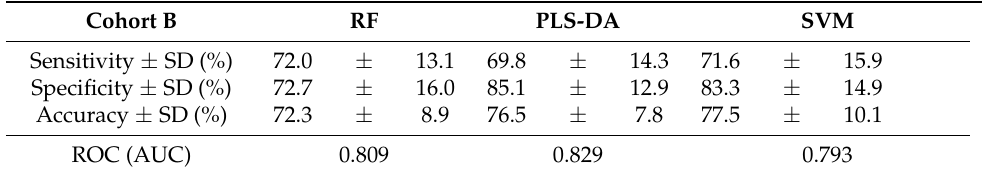
Figure 4. Receiver operating characteristic (ROC) curve analysis calculated from a partial least squares discriminant analysis (PLS-DA) model performed on Cohort B. Point A shows the point of maximum sensitivity and point E shows the point of maximum specificity when the model is tuned to give a specificity or sensitivity of 45%, respectively, as highlighted by the light blue square. Point B shows the point of maximum sensitivity and point D shows the point of maximum specificity when the model is tuned to give a specificity or sensitivity of 60%, respectively, as highlighted by the darker light blue square. Point C represents the balance point between sensitivity and specificity, whilst remaining in the target regions (Sens, sensitivity; Spec, specificity; AUC, area under the ROC curve). Table 3. Statistical performances of random forest (RF), partial least squares discriminant analysis (PLS-DA), support-vector machine (SVM), and receiver operating characteristic (ROC) analysis performed on Cohort B (AUC, area under the ROC curve; SD, standard